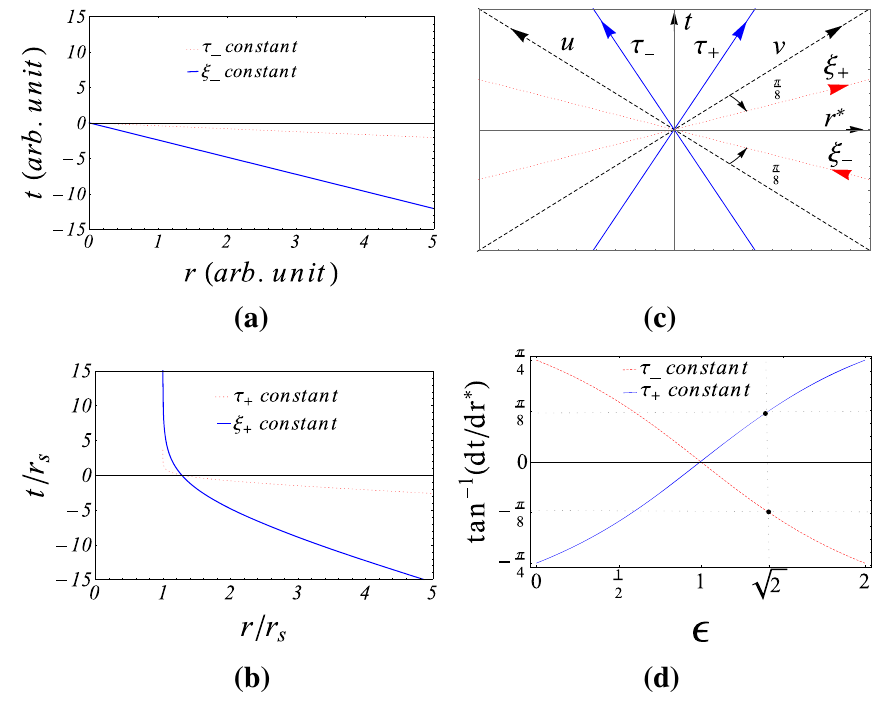
Fig. 1 a The spacelike and timelike hyper-surfaces for the observer O − are drawn with arbitrary unit using dotted red line and solid blue line √ respectively for (cid:10) = 2. b The spacelike and timelike hyper-surfaces for the observer O + are drawn using dotted red line and solid blue line √ respectively for (cid:10) = 2. c The spacelike, timelike and null hyper-surfaces are drawn using dotted red line, solid blue line and dashed black line √ respectively for (cid:10) = 2. d The angle made by the constant τ − and τ + hyper-surfaces in t − r (cid:7) plane for different values of the parameter